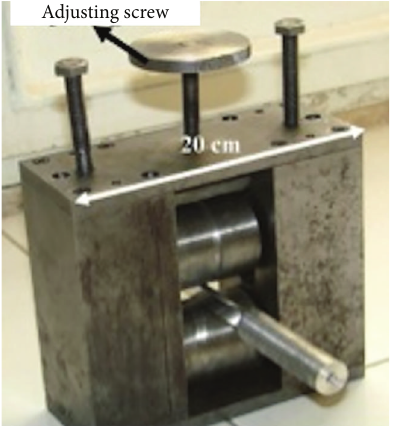
Figure 4: The fixture used for DR the specimens [38].